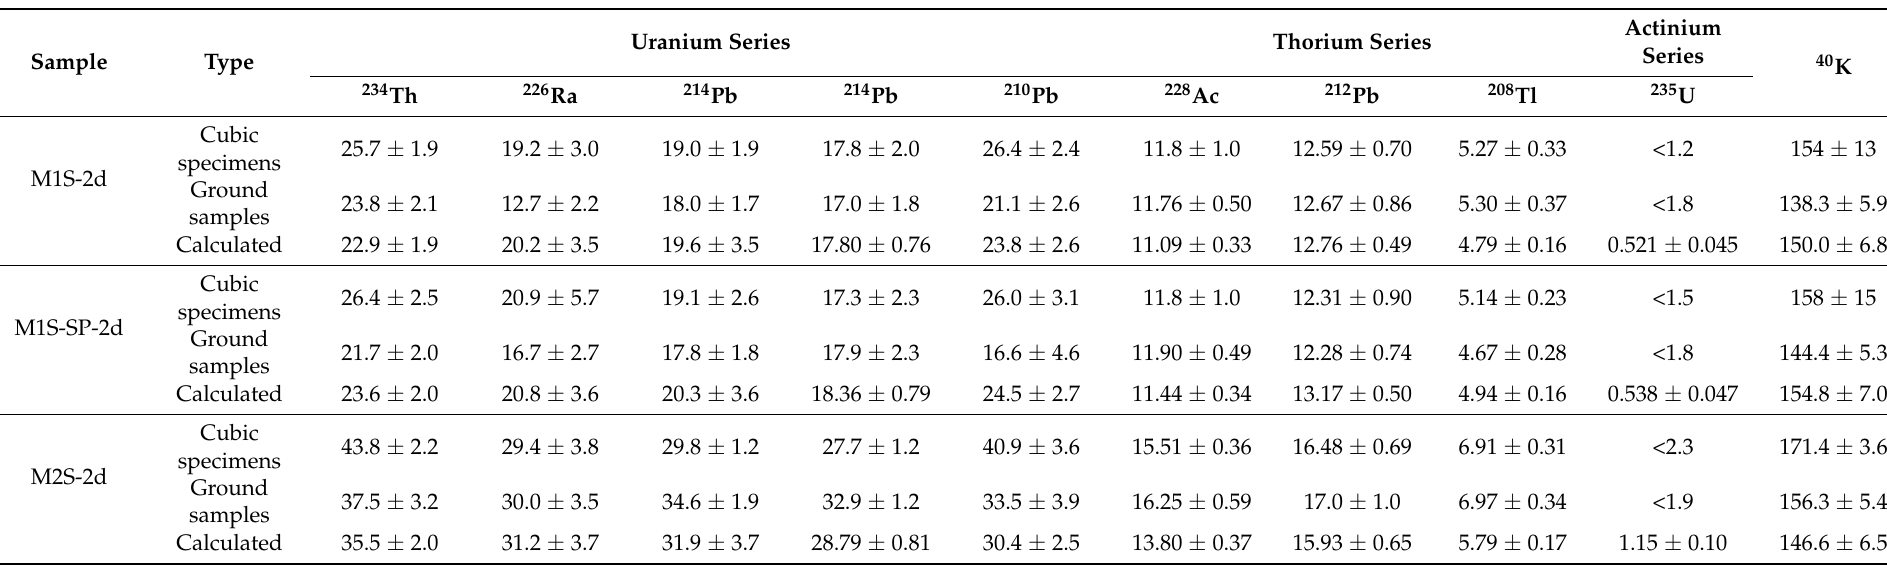
The uncertainties cited are for a coverage factor k = 2. Table 10. Activity concentrations (Bq kg − 1 ) for: (a) 5-cm cubic hardened hybrid cement specimens; (b) ground mortars; and (c) values calculated from the percentage of individual components used to prepare mortars with siliceous